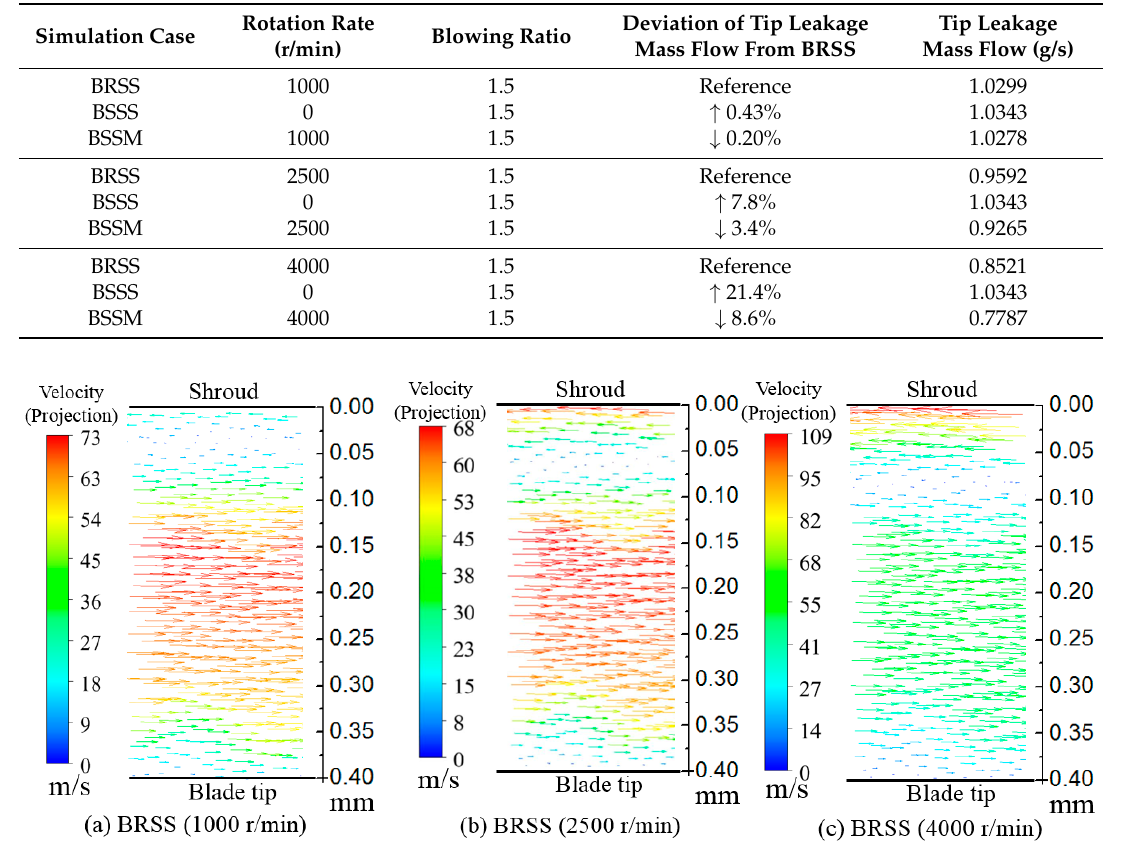
Figure 10. Velocity vectors on cut 4 at BR = 1.5 in BRSS case: ( a ) 1000 r/min; ( b ) 2500 r/min; ( c ) 4000 r/min.